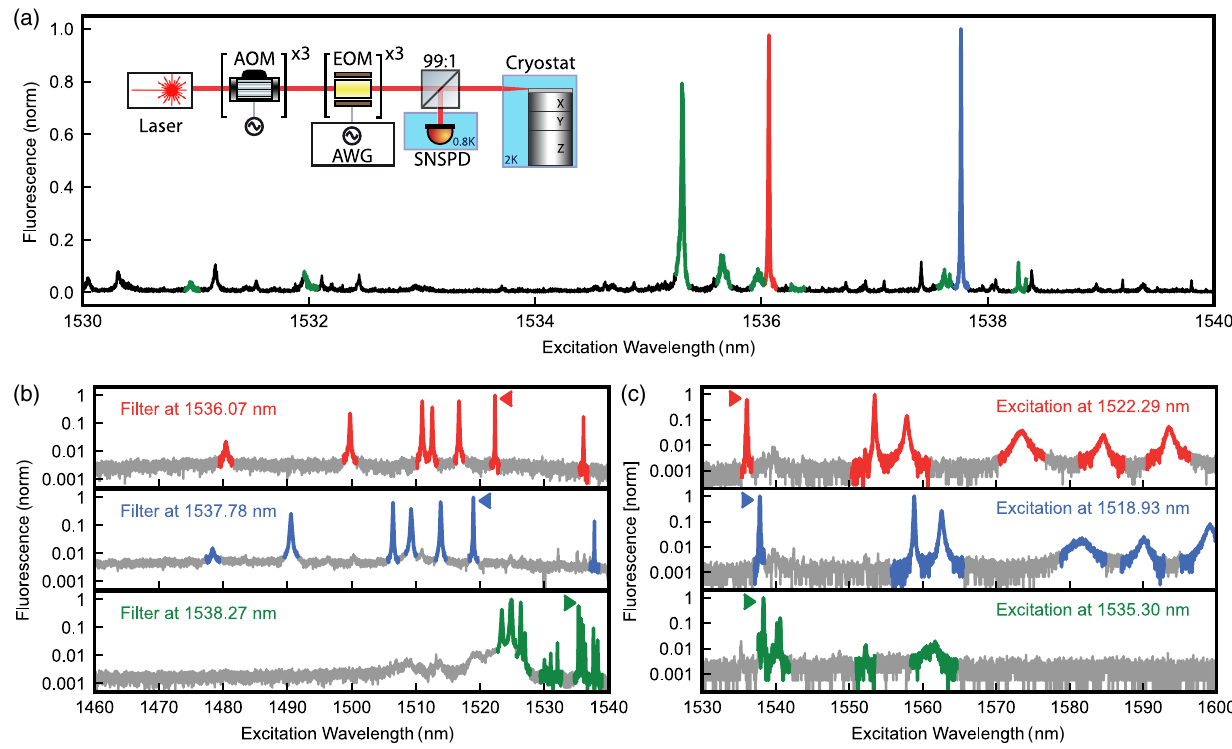
FIG. 2. Spectroscopy of erbium-implanted silicon waveguides. (a) Inset: experimental setup. A laser is switched by acousto-optic (AOM) and phase-modulated by electro-optic modulators (EOM). A 99 ∶ 1 beam splitter is used to guide the light emitted from the sample in the cryostat to single-photon detectors (SNSPD). Main graph: scanning the excitation laser frequency results in several narrow fluorescence peaks, here shown for the FZ sample. (b) Insertion of a narrow-band optical filter, tuned on resonance with one of the three most prominent peaks (color coding), eliminating the broadband background observed otherwise (which is strongest in the shown CVD samples). Scanning the excitation laser then reveals the excited-state crystal fields of the individual sites. (c) Keeping the laser on resonance with one of the main peaks while scanning the filter, which gives the ground-state crystal fields. The filled triangles in (c) and (b) mark the filter and excitation laser positions, respectively, in (b) and